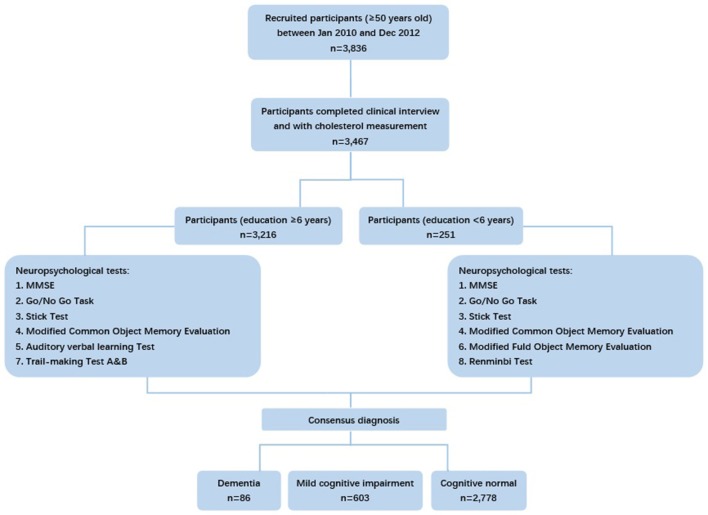
Flowchart of participants' recruitment and deciding neuropsychological tests in our study.